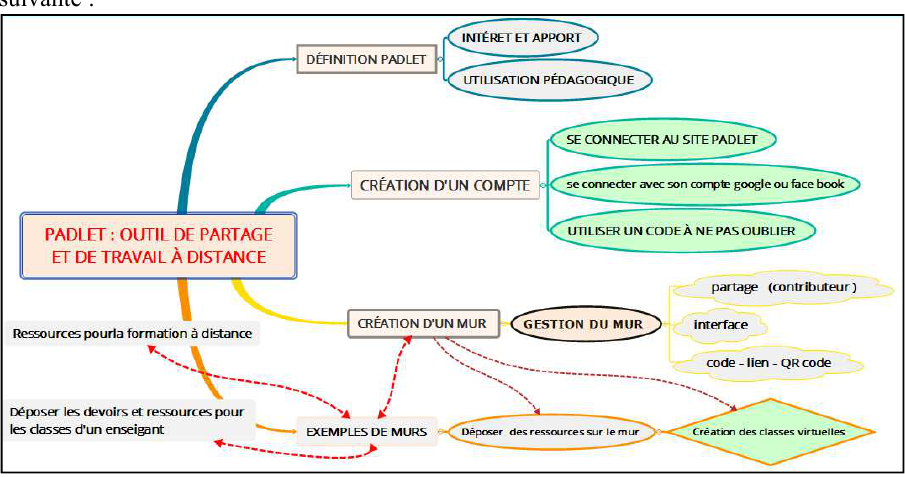
Fig. 8. Simulation du problème en physique par Geogebra.